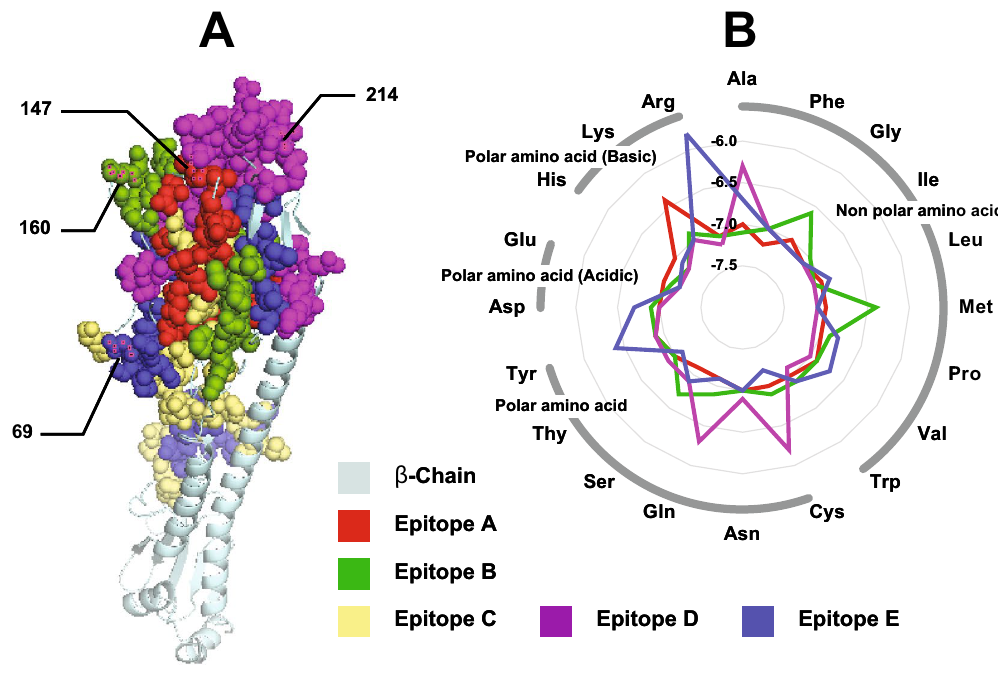
Figure 4. ( A ) 3D structure of hemagglutinin protein (HA) indicating diversifying epitope sites for Bangladeshi strain; ( B ) changes in host receptor binding affinity for alterations in the amino acid, at the positions of diversifying epitope